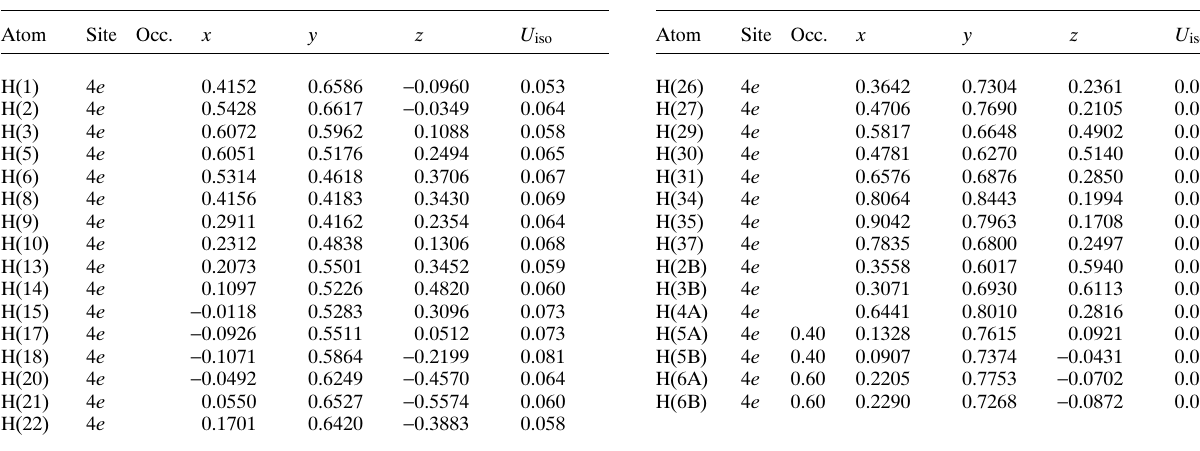
Table 2. Atomic coordinates and displacement parameters (in Å 2 )